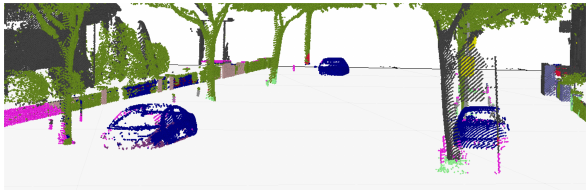
Figure 7. Visualization of the 3D labeled data with removed ground points. The result of the third car extraction processing step (3). The color map: Same as in Figure 6 Figure 5. Riegl VMX-250 mounted on the top of the volkswagen T4.